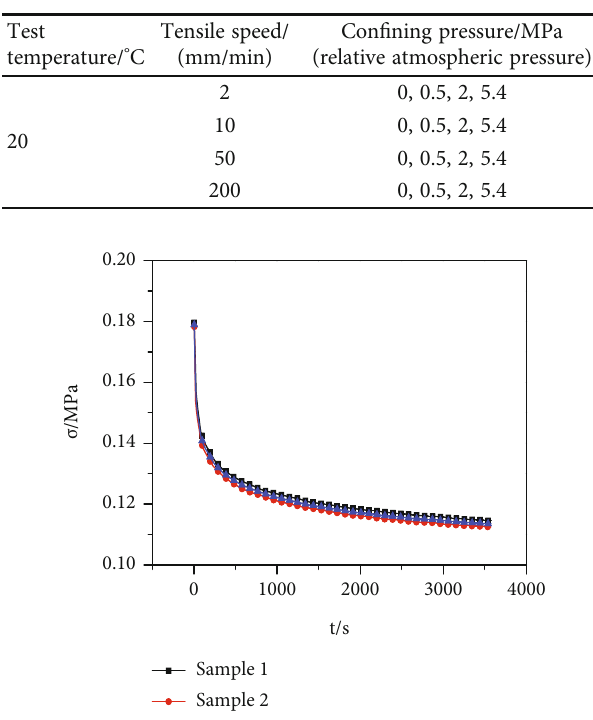
Figure 3: The propellant specimen size and fi xture. Table 2: The detailed experimental plan.